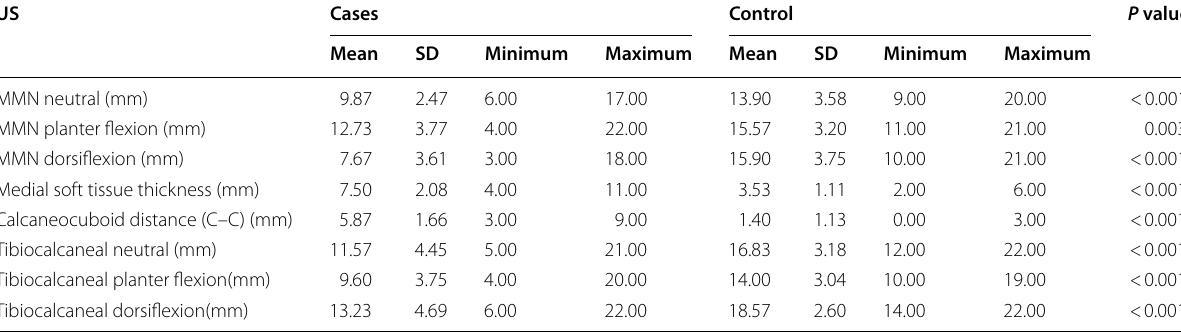
Table 3 Comparison of the sonographic parameters between cases and controls